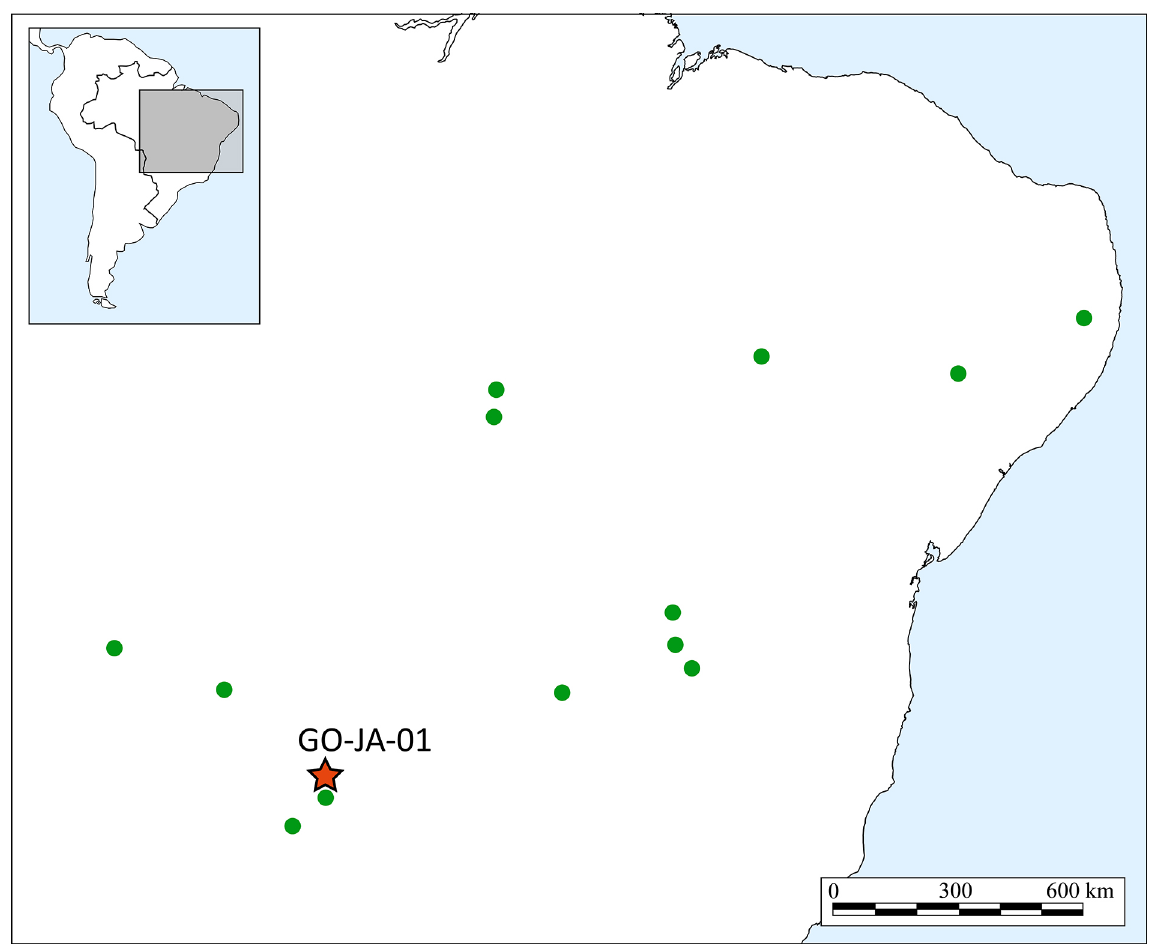
Figure 1. Carte des principaux sites du technocomplexe Itaparica et localisation de GO-JA-01. Figure 1. Map of main sites of the Itaparica technocomplex and location of GO-JA-01 rockshelter. 1.1. Les pièces façonnées unifacialement du technocomplexe